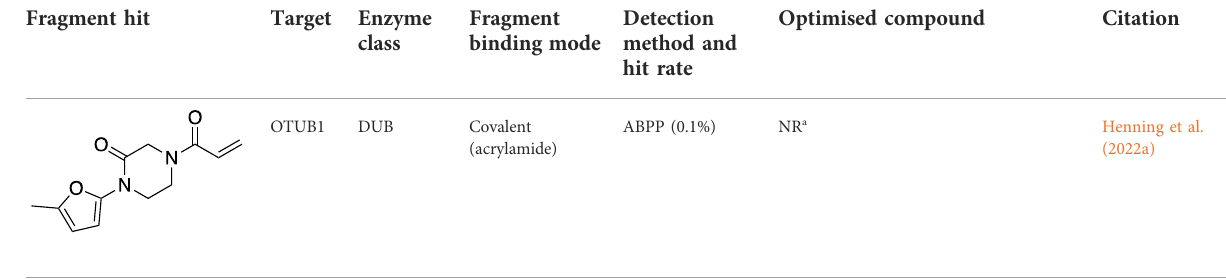
TABLE 1 ( Continued ) Summary of fragment hits and fragment-derived modulators of ubiquitin system proteins. Pharmacophores from original fragment hits which were retained in optimised compounds are highlighted in blue/green/purple. Potency/binding af fi nity of optimised compounds was de fi ned individually in each report (see